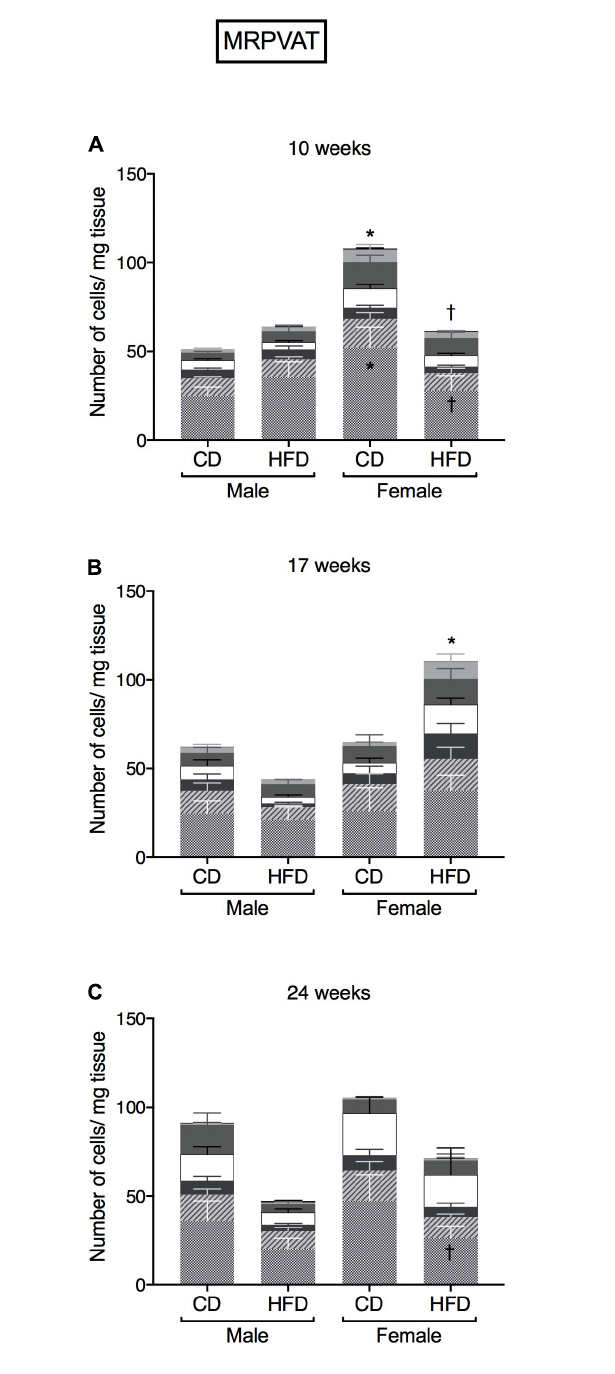
FIGURE 2 | Overall snapshot of adaptive and innate immune cells in PVATs along the time-course of development and progression of hypertension. Immunophenotyping of mesenteric resistance PVAT (MRPVAT) and thoracic aortic PVAT (APVAT) in male and female Dahl S rats fed a control diet (CD) or a HFD for 10 (A,D) , 17 (B,E) , or 24 (C,F ) weeks. Bars represent means ± SEM for the absolute cell counts of each immune cell type, normalized to tissue weight (in milligram). Number of animals is indicated by N. A P < 0.05 by two-way ANOVA with Tukey’s test for multiple comparison, was considered statistically significant. * and † inside the stacks in the graph represent a significant difference in the specific stack of immune cells between the sexes within each diet and between the diets within each sex respectively. * and † outside the stacks in the graph represent a significant difference in the sum total of immune cells between the sexes within each diet and between the diets within each sex